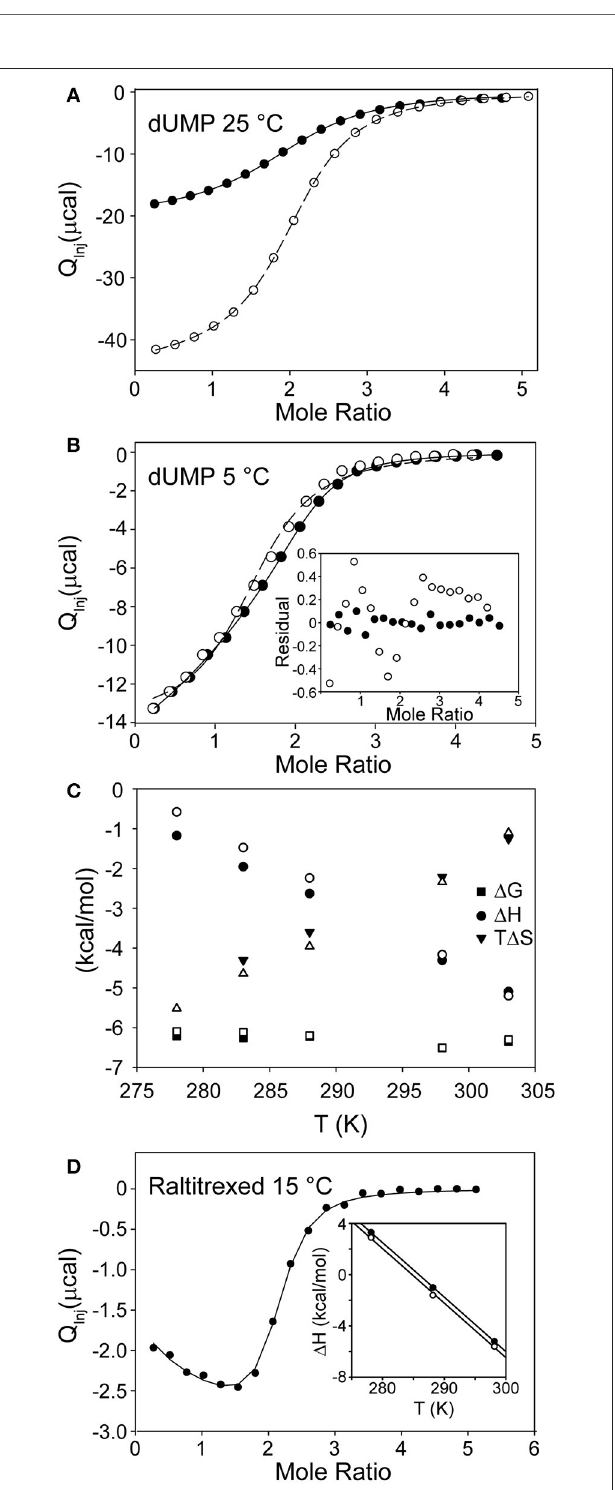
FIGURE 3 | ITC of substrate and cofactor binding to TS. (A) Global fit of dUMP binding isotherms using two different syringe concentrations (open and filled circles) at 25 ◦ C. The modified general model (see text) was used for fitting (Sapienza et al., 2015). (B) Fits of dUMP binding isotherm at 5 ◦ C using two different models, the single site model with stoichiometry of two (open circles) and the modified general model (filled circles, which are shifted